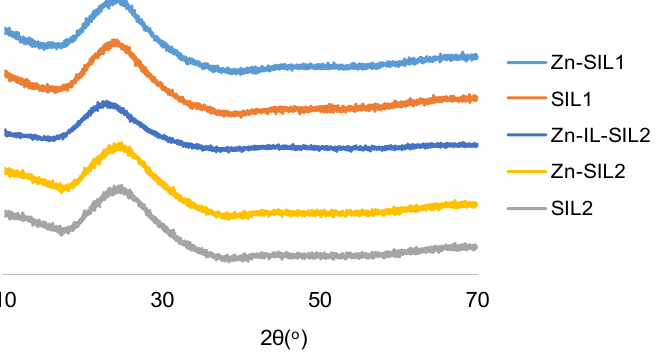
Figure 6. X-ray diffraction patterns of Zn(II)-AHBD-impregnated silica aerogels and blank silica aerogels.